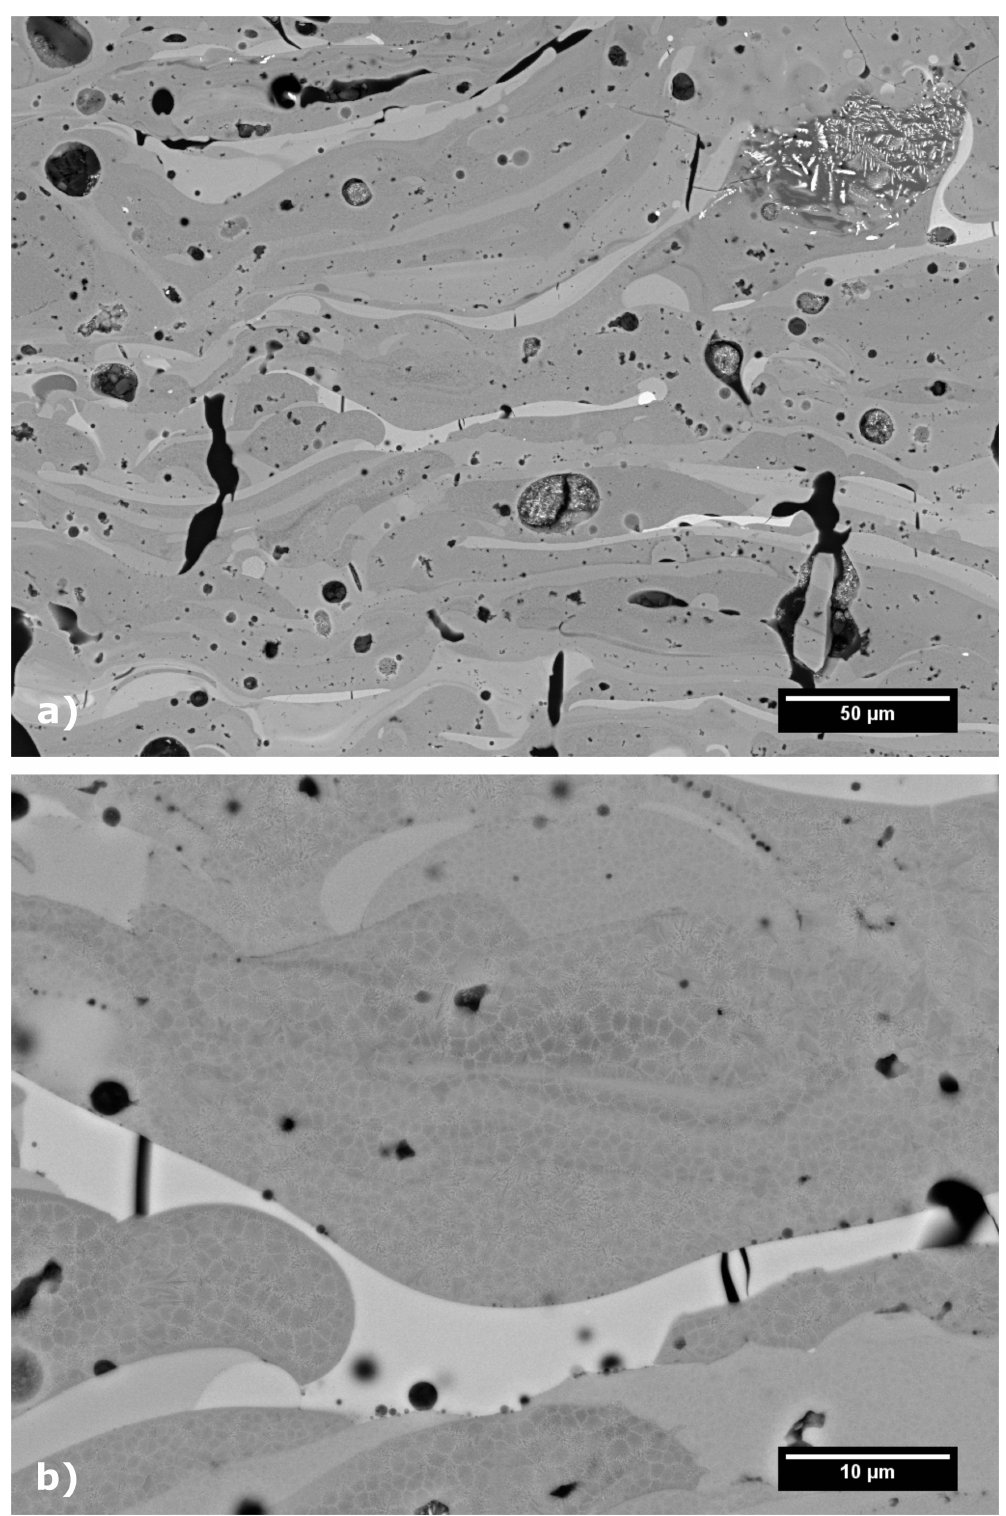
Figure 5. Cross-section of furnace heat-treated sample at 1050 ◦ C and 5 min dwell ( a ); magnified view ( b ). Surface heat treatment by laser and plasma also resulted in the coating crystallization. The degree of crystallization and microstructural changes in the sample depended on treatment